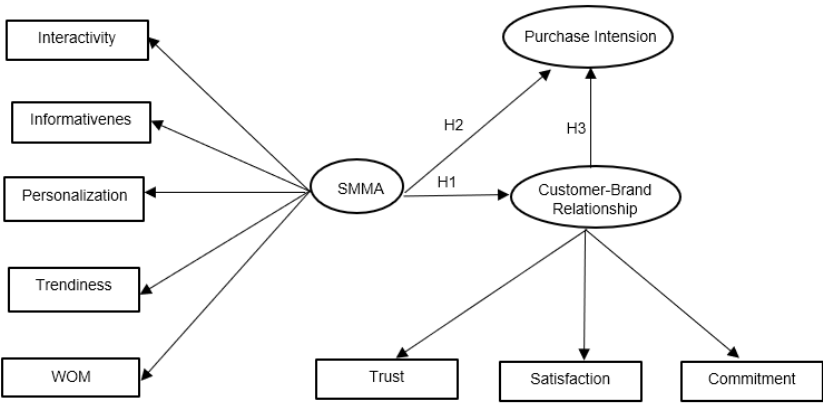
Figure 1. Conceptual model of the hypotheses testing.